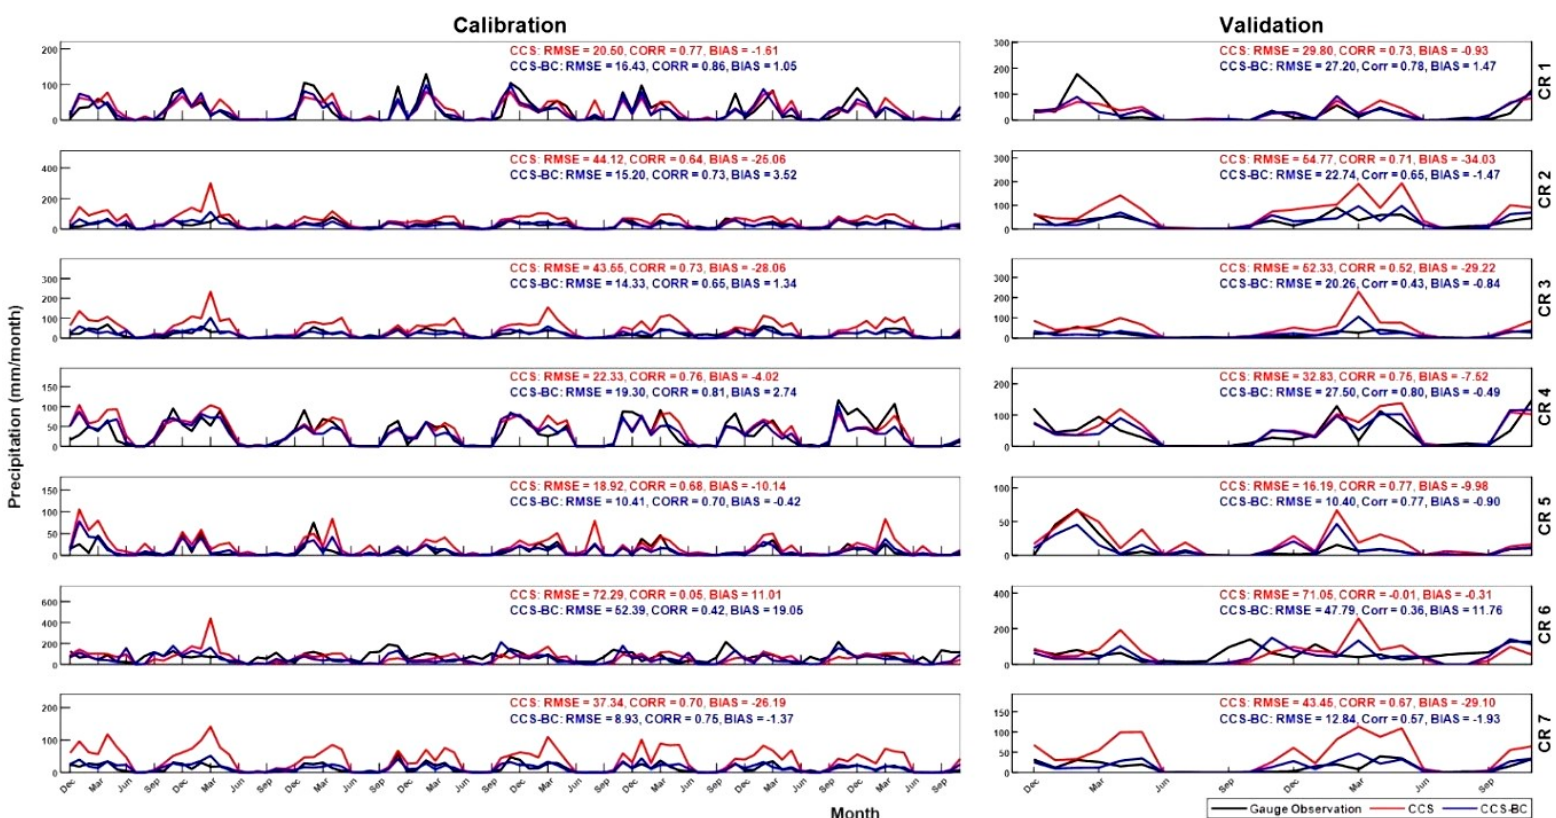
Figure 9. The areal average of the monthly precipitation timeseries in the gauged pixels in each CR for the calibration and validation periods.